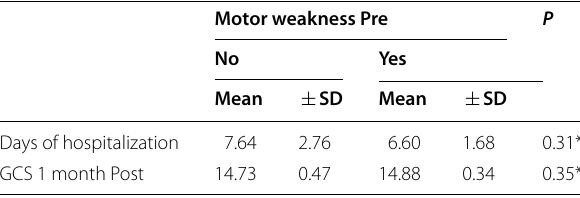
0.06, respectively =